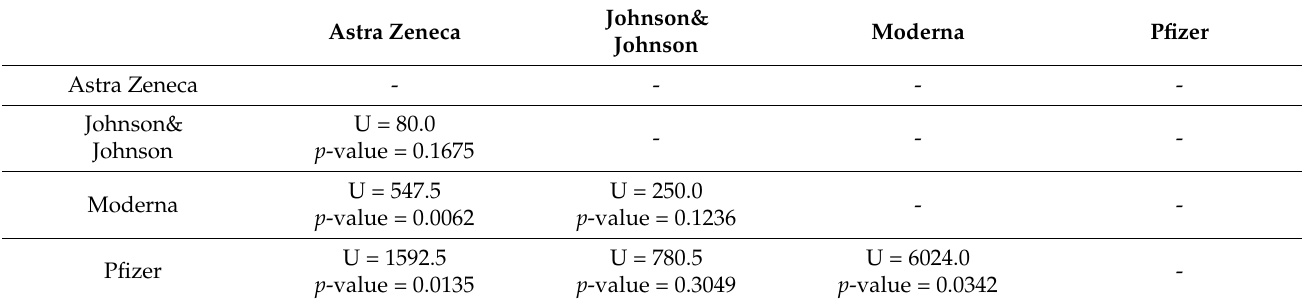
Table 6. Antibodies levels after particular SARS-CoV-2 vaccines.